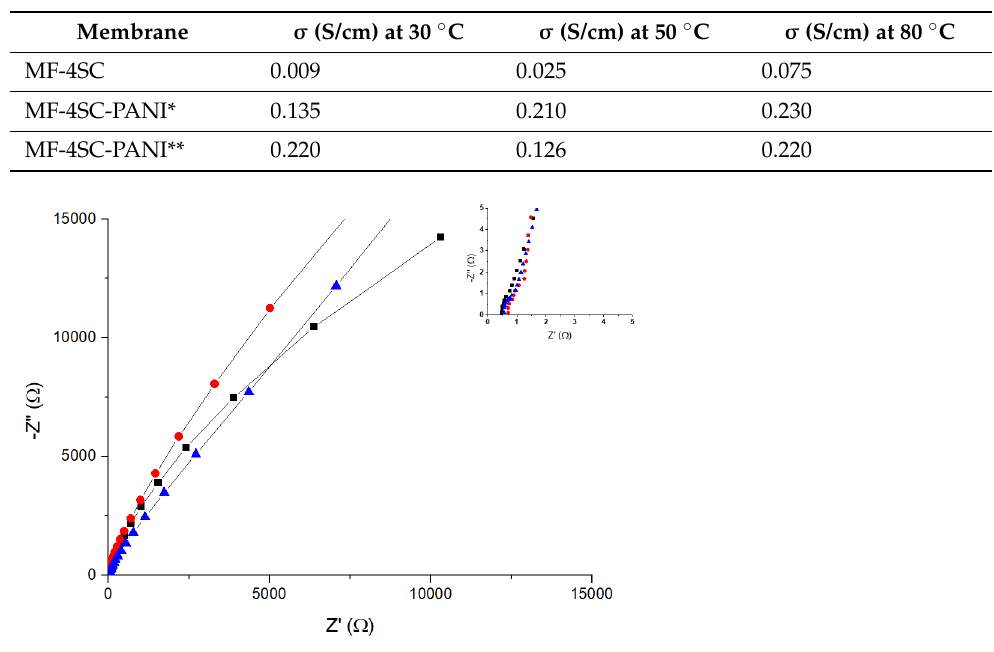
Table 2. Conductivity values of the MEA determined from the fitting of the polarization curves shown in Figure 8 at different temperatures.